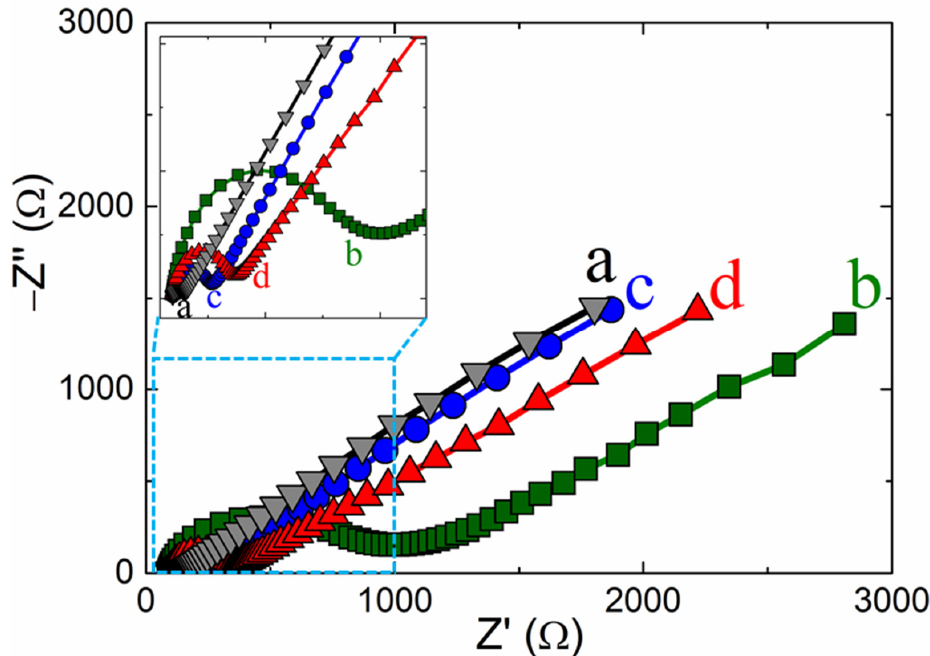
Figure 4. Electrochemical impedance spectroscopy of (a) bare GC, (b) p-CFA/GC, (c) ERGO/GC, and (d) p-CFA@ERGO/GC-modified electrodes in 0.1 M KCl containing 5 mM [Fe(CN) 6 ] 4 − /3 −